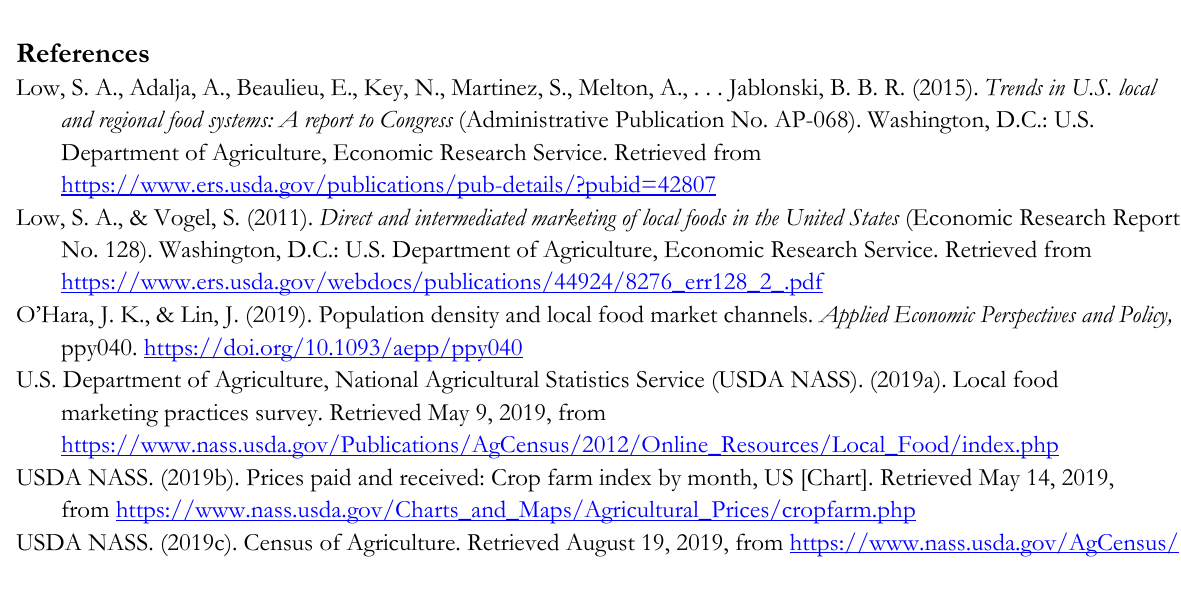
behind this trend. Additionally,